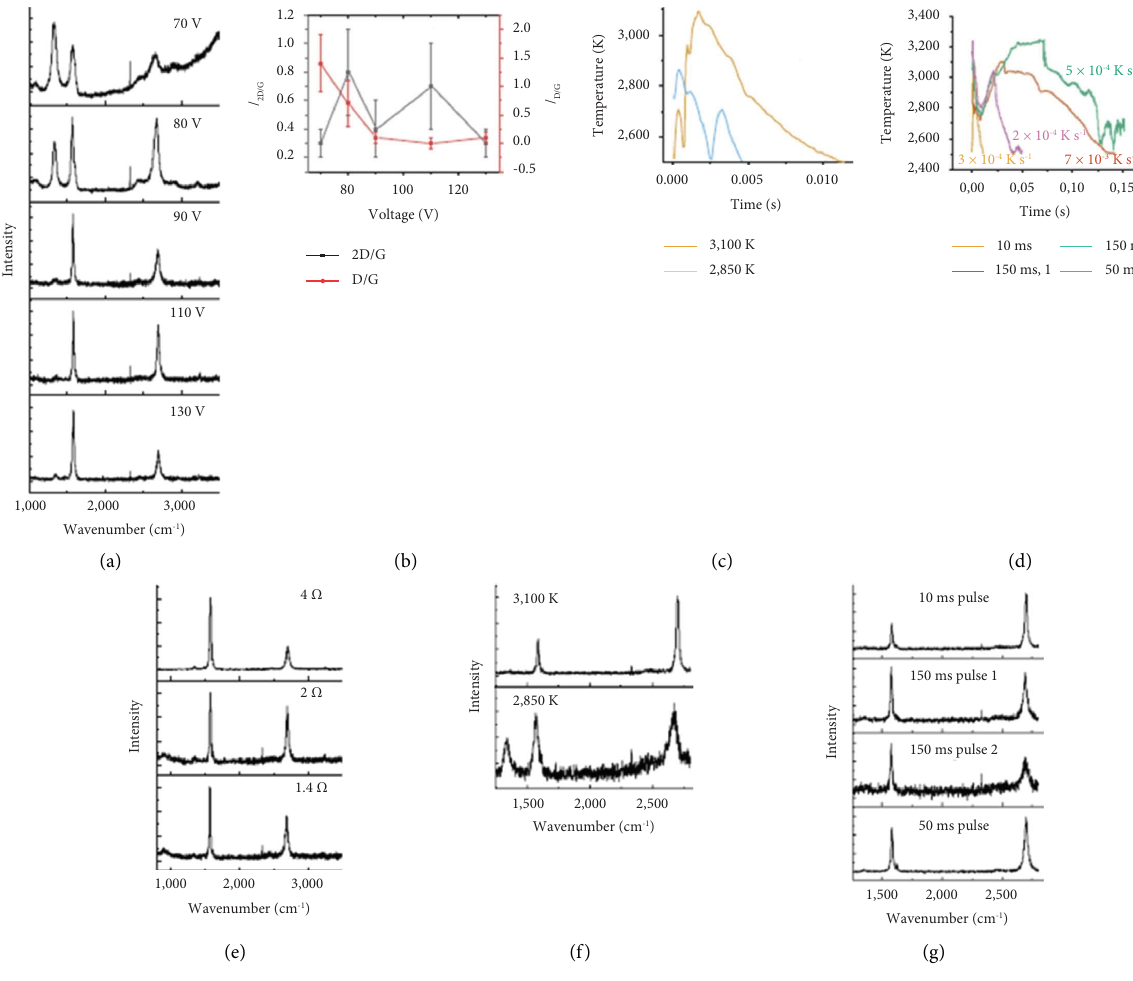
Figure 21: (a) Raman spectra of carbon black after being processed using FJH at the diferent initial voltage at which the capacitor bank is discharged. (b) Ratio of 2D and D peaks to G peak. Ideally, FJH graphene should have low D/G ratio (shows low defect concentration) and high 2D/G ratio (indicates turbostratic stacking). (c and f) Temperature vs time graph of FJH graphene production with Raman spectra. (d and g) Temperature vs fash duration with cooling rates and the Raman spectrum of the resulting graphene. (e) Raman spectra of FJH graphene obtained from carbon black under varying compressions [76,